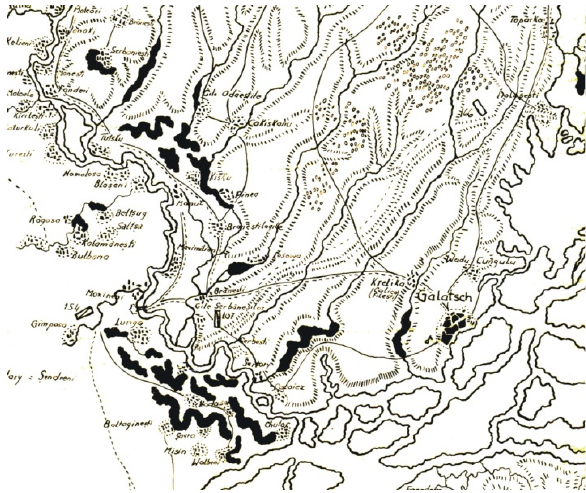
Figure 3. Forest bodies on the map of Moldavia [62].